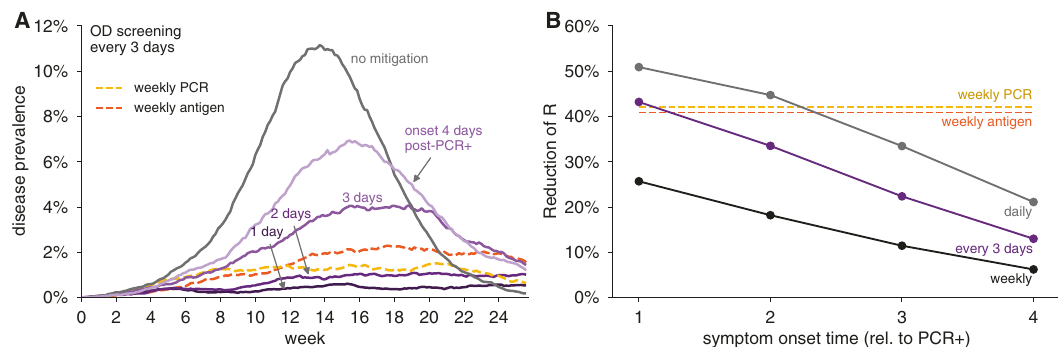
Fig. 2 Impact of the timing of olfactory dysfunction onset on its effectiveness to limit viral spread. A Examples of viral spread in fully-mixed community of 20,000 individuals performing olfactory dysfunction (OD) screening every 3 days. olfactory dysfunction is modeled to be present in 75% of infected individuals, and to last 7 days. Timing of olfactory dysfunction is varied from one to 4 days after viral loads reach ~1000 virions/ml (purple shaded lines as indicated). No mitigation is shown as black line. B Reduction of reproductive number R with different testing regimens showing the impact of timing of symptom onset with weekly (black line), every 3 days (purple line), or daily (gray line), testing for olfactory dysfunction. For comparison, weekly RT-PCR testing with a 1 day turnaround (dashed yellow line) and weekly antigen testing (dashed red line) are shown. We consider 80% participation in testing and 20% COVID-19-independent olfactory dysfunction in both panels.